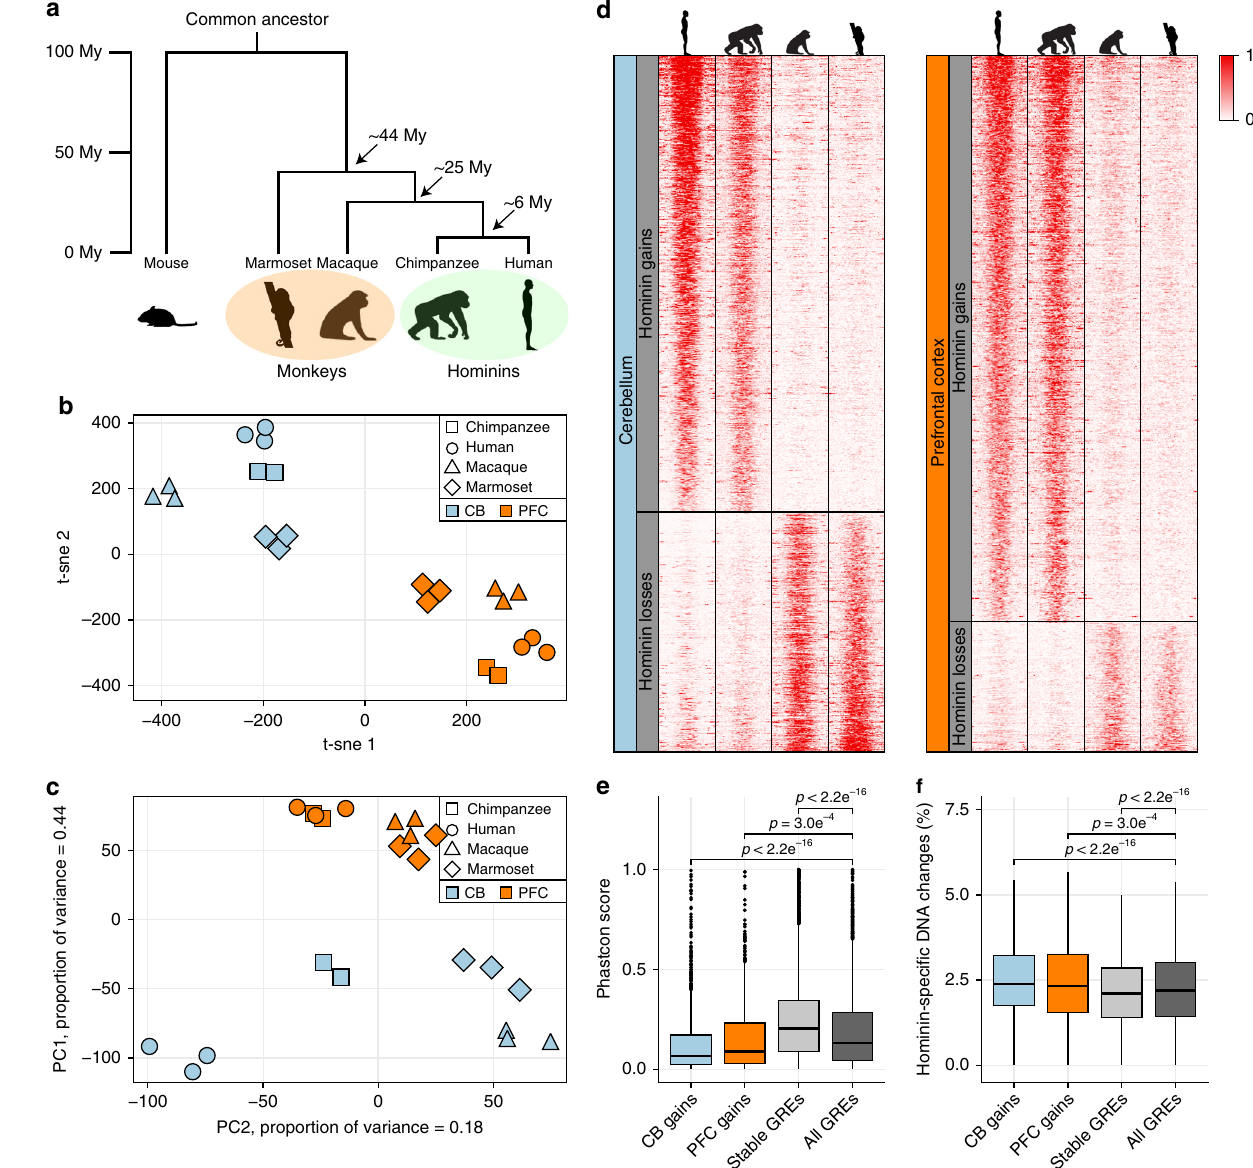
Fig. 1 Identi fi cation of hominin-speci fi c regulatory changes in brain tissue. a Schematic representation of the primate phylogenetic tree with time indication of the major branch points. b t-Distributed Stochastic Neighbor Embedding (t-sne) analysis of all H3K27ac-enriched GREs with orthologs on all four primate genomes ( n = 37,308). Axes indicate semantic space (CB cerebellum, PFC prefrontal cortex). c PCA analysis of the same regions as in ( b ), shown for the fi rst two principal components. d Heatmap showing H3K27ac enrichment on scaled hominin-speci fi c regulatory changes in both cerebellum and prefrontal cortex. Heatmap colors indicate H3K27ac enrichment (rpm). CB gains n = 713; CB losses n = 374; PFC gains n = 685; PFC losses n = 158. e Conservation scores (20 mammals) using PhastCon as de fi ned by UCSC for hominin-speci fi c gains and evolutionary stable GREs compared to all here identi fi ed GREs. Dissimilarities between distributions were calculated using a Student ’ s t test. f Analysis as in ( e ) for hominin-speci fi c nucleotide changes. Bottom and top of the box plots are the fi rst and third quartile. The line within the boxes represents the median and whiskers denote interval within 1.5× the interquartile range from the median, outliers are depicted as points. Source data are provided in Source Data fi